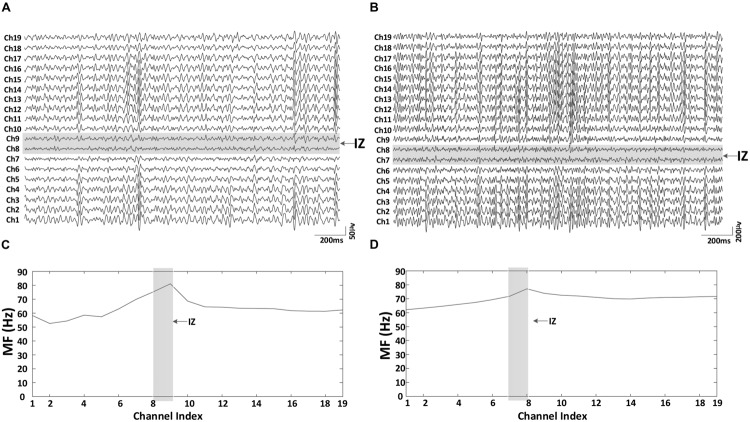
An example of the 19 bipolar surface EMG signals and the corresponding MF for both paretic and contralateral muscles (Subject 1, 30% MVC). (A) Paretic side EMG, (B) contralateral side EMG, (C) paretic side surface EMG median frequency (MF), and (D) contralateral side surface EMG MF. The two consecutive channels marked gray indicate the innervation zone. MF was largest for channels close to estimated innervation zone in the 19 bipolar channels for both paretic and contralateral muscles.